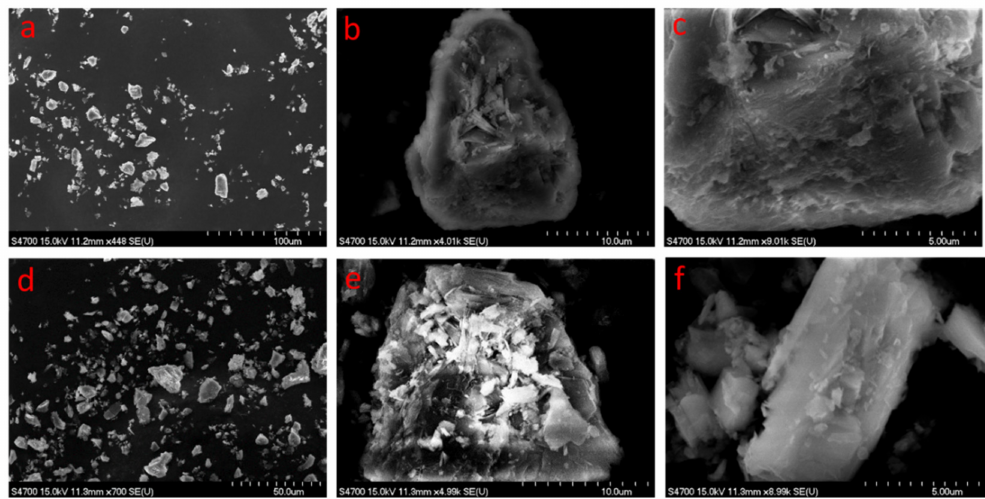
Figure 13. The SEM images of calcined NV-Na at a 100 µ m scale ( a ), a 10 µ m scale ( b ), and a 5 µ m scale ( c ), and that of 30 min HCl NV-Na at a 50 µ m scale ( d ), a 10 µ m scale ( e ), and a 5 µ m scale ( f